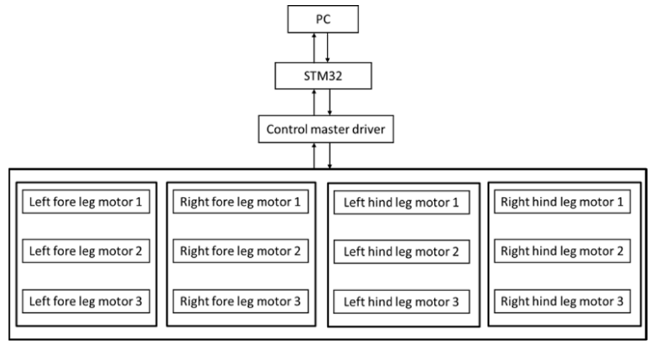
Figure 14. Control chart of the quadruped robot. When receiving the command, each actuator will return to a status package. The actual rotation angle, torque, voltage, current, and temperature information of the actuator can be obtained from the status package and then returned from the control master driver to the